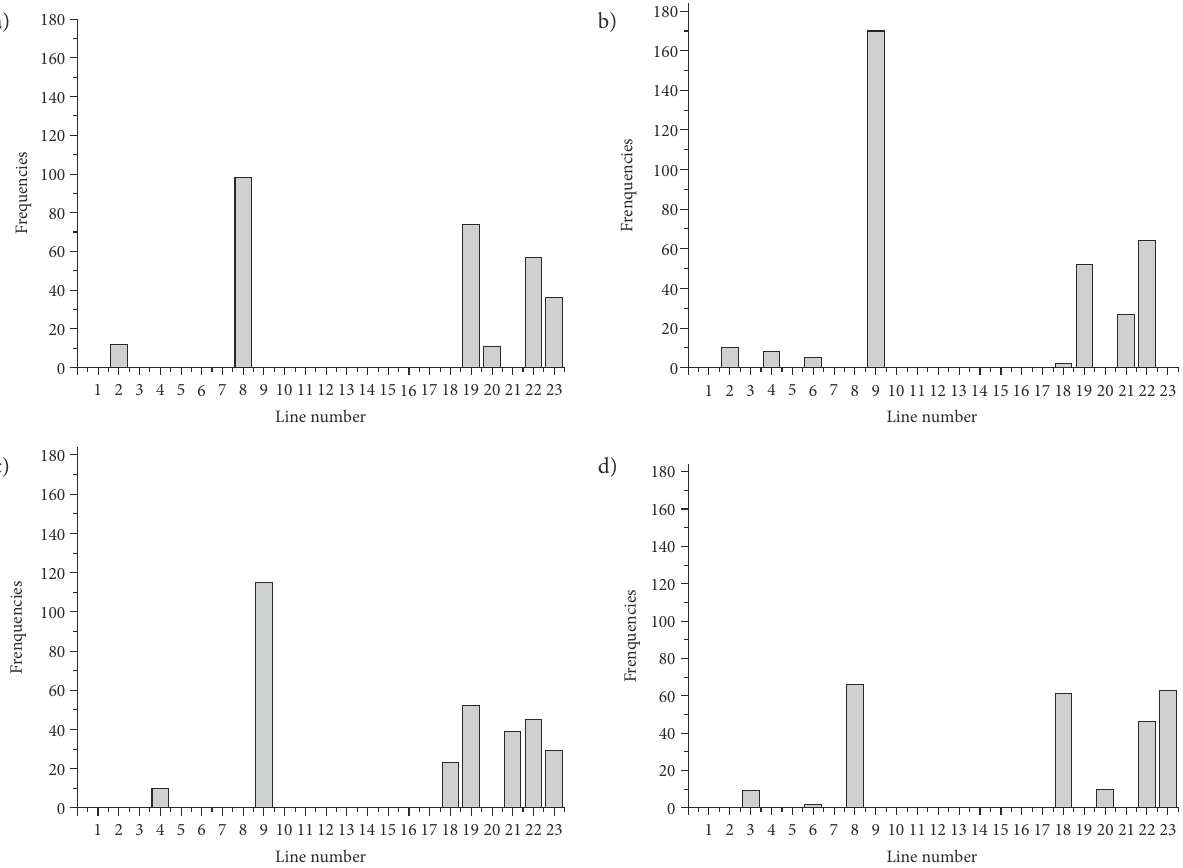
Figure 8. Frequencies of optimal lines for different values of β ij : a – β ij = 0; b – β ij = 0.05; c – β ij = 0.1; d – β ij = 0.2